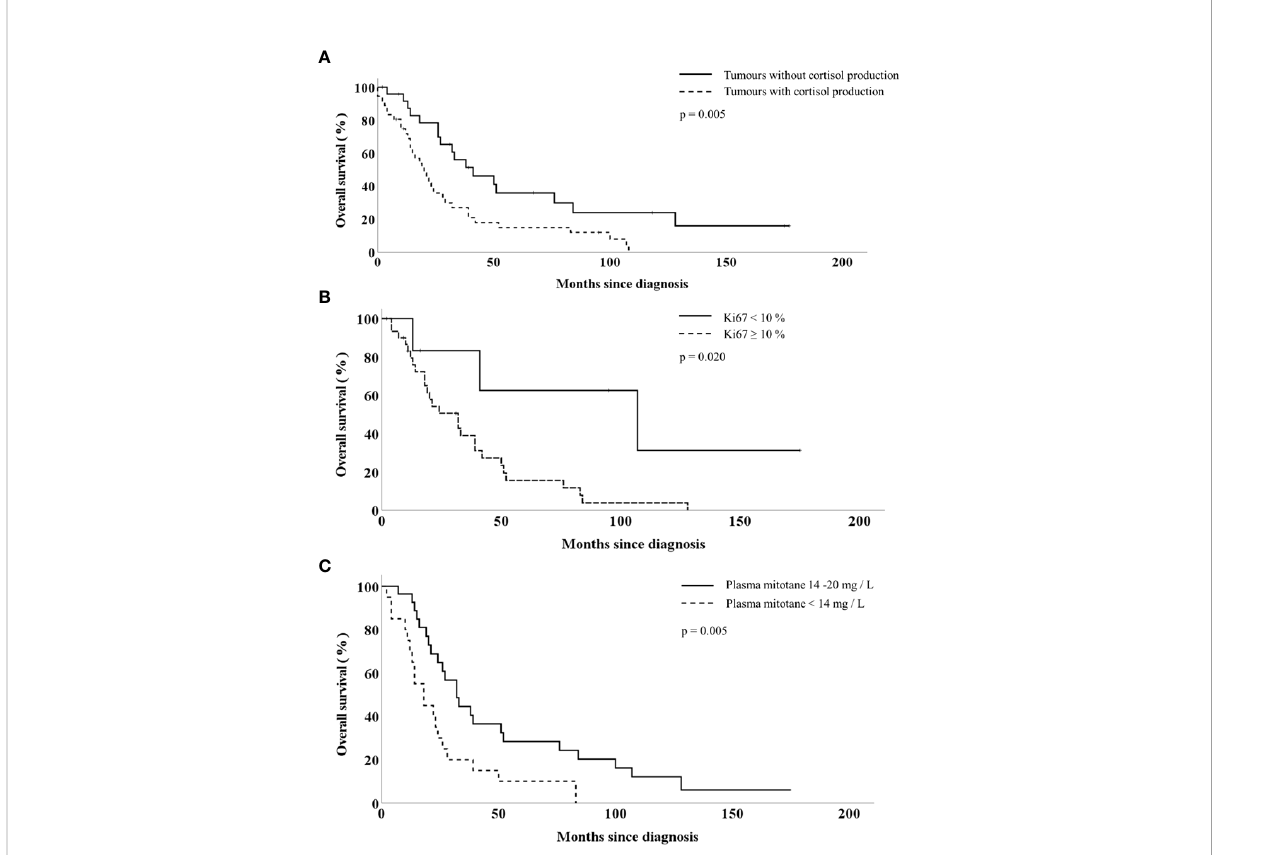
FIGURE 1 Overall survival of patients with adrenocortical cancer according to the tumour cortisol production (A) , tumour Ki67-index (B) and the plasma mitotane concentration (C)